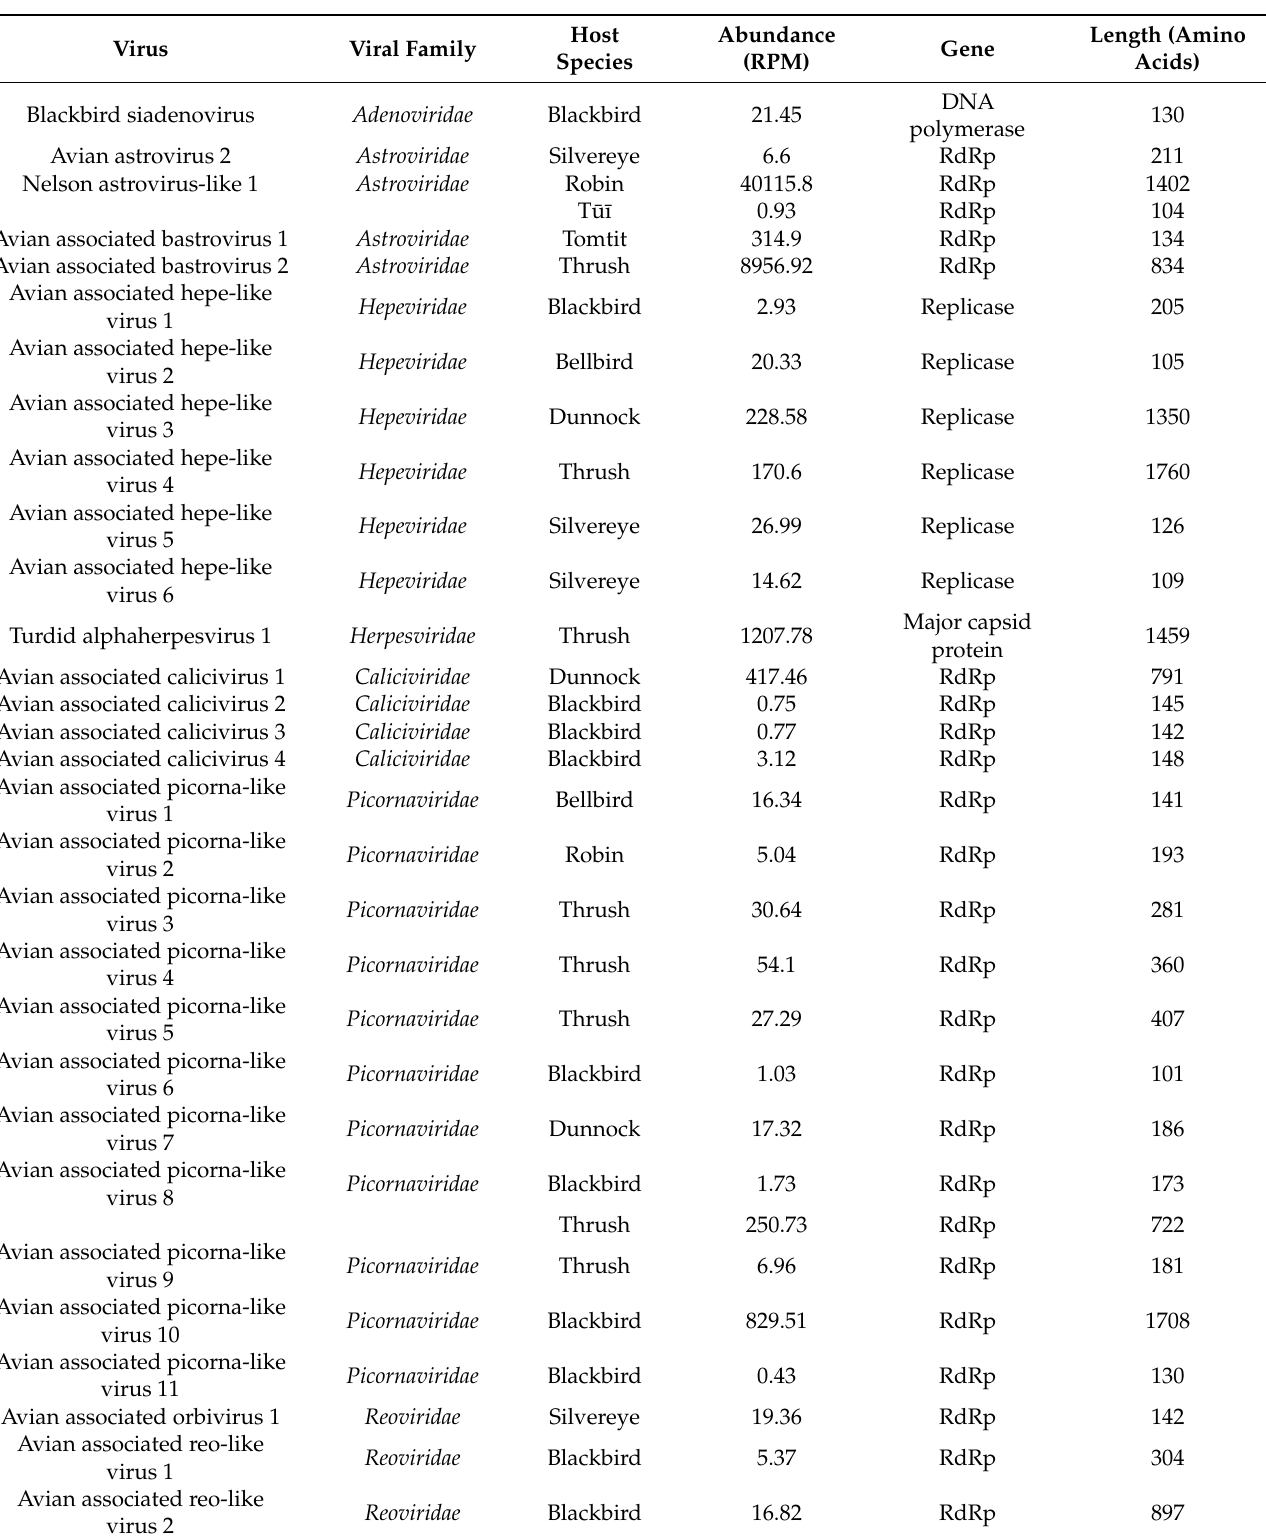
Table 3. The details of each virus identified—the viral family, host species, the abundance, expressed as reads per million (RPM), the gene used in the phylogenetic trees, and the length in amino acids of that gene sequence. RdRp = RNA dependent RNA